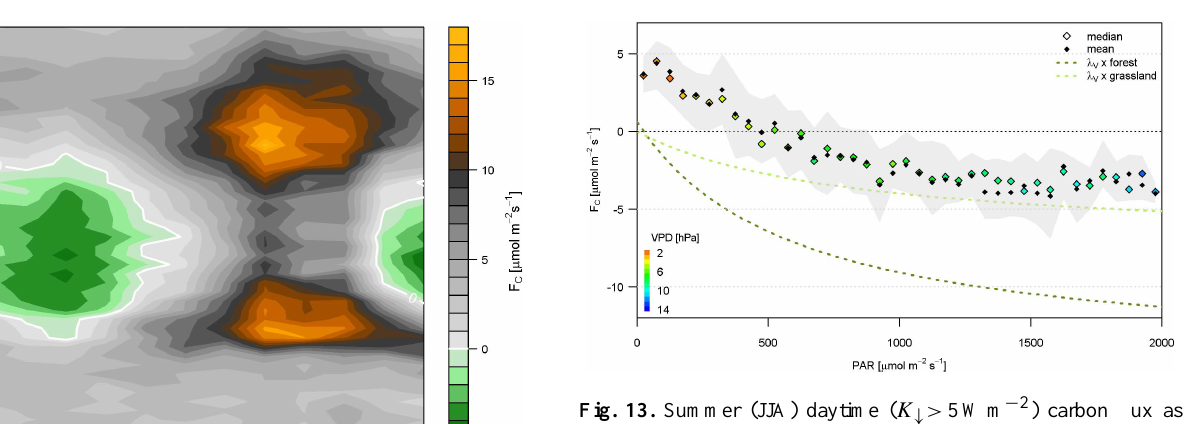
Fig. 13. Summer (JJA) daytime ( K ↓ > 5Wm − 2 ) carbon flux as a function of photosynthetically active radiation (PAR, in bins of 50µmolm − 2 s − 1 ). Shaded area is the interquartile range; median values coloured by median vapour pressure deficit (VPD); the models of Schmid et al. (2000) for a mixed deciduous forest ecosystem and Flanagan et al. (2002) for temperate grassland, scaled by the vegetation fraction for Swindon, are